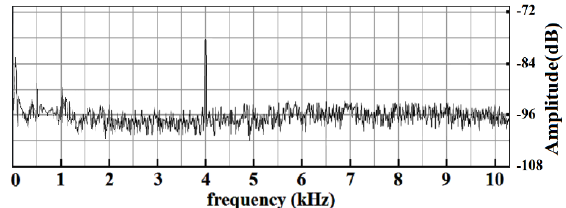
Figure 6. Amplitude spectrum of the homodyne LDV output with the vibrating glass and PZT.